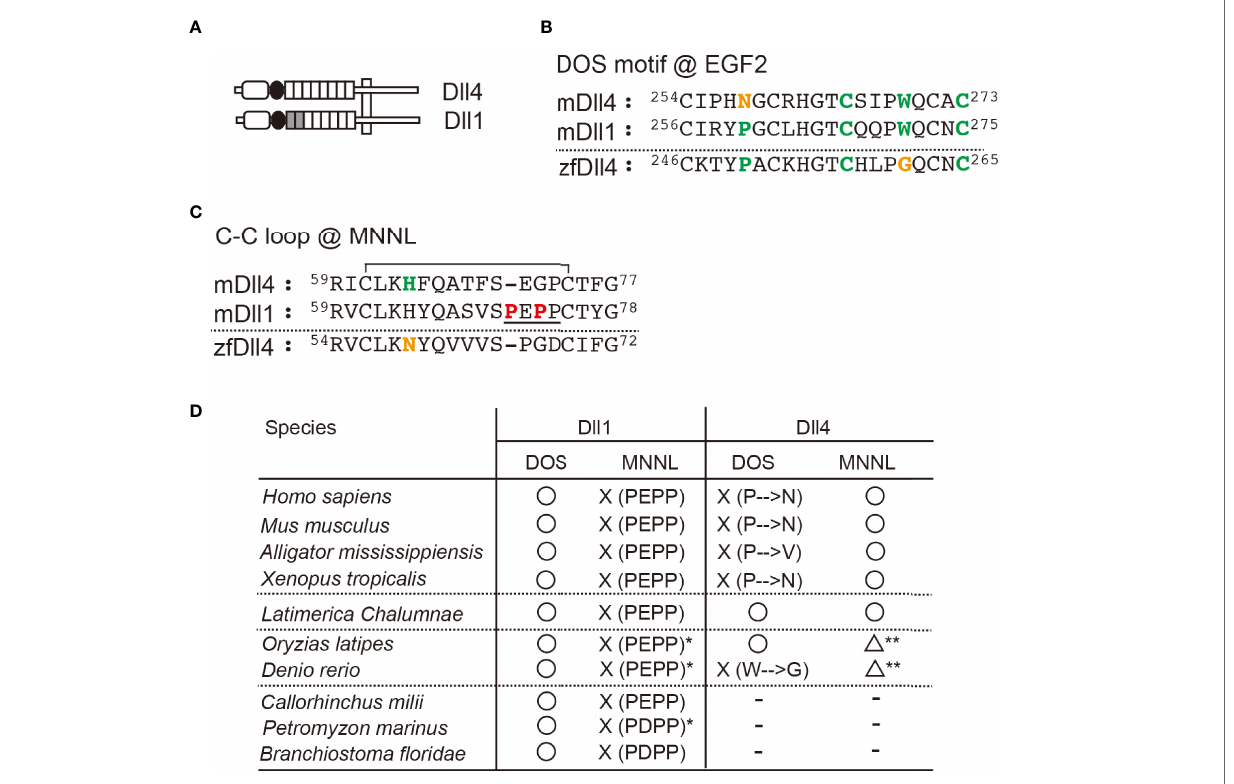
FIGURE 1 | Characteristic features of Dll1 and Dll4. (A) Schematic structure of Dll1 and Dll4. The MNNL and DSL domains are represented by an open rectangle with round corners and a fi lled circle, respectively. The EGF-like repeat is shown by square, and the fi rst and second repeats retaining the DOS motif in Dll1 are fi lled. Both Notch ligands are present on the cell membrane (vertical square). (B, C) Amino acid (AA) sequence comparison of the DOS motif in the second EGF-like repeat (B) and the C – C loop in MNNL domain (C) between murine (m) Dll4, Dll1, and zebra fi sh (zf) Dll4. Numbers on the AA sequences represent the position from the N-terminus. The AAs in the DOS motif ( B , bold green) and their substitution ( B , bold orange) are labeled. Similarly, histidine in the C – C loop (C) , contributing to the direct binding with Notch ( C , bold green) and its substitution ( C , bold orange), is also labeled. The C – C loop in mDll1 contains a characteristic proline-rich AA region ( C , underlined with unique prolines, bold red). Line over the sequence represents the disul fi de bridge between cysteine residues (61st to 74th in mDll4). (D) Characterization of the conservation of DOS motif (DOS) and the predicted functionality of MNNL domain (MNNL) in Dll1 and Dll4 homologs in various species. ○ , functional; ☓ , non-functional; △ , attenuated (predicted); − , absent. *One of the orthologs retains PEPP or PDPP residues. **The histidine residue (bold green in C ) at the C − C loop pf MNNL domain is replaced with asparagine (bold orange in C